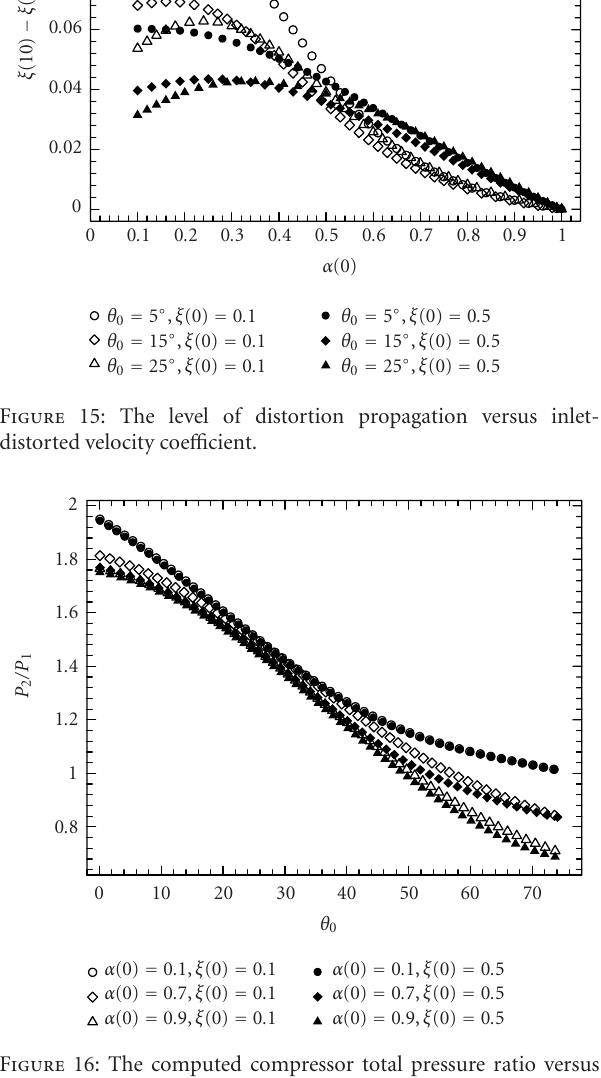
Figure 14: The level of distortion propagation versus inlet inci- dence angle.